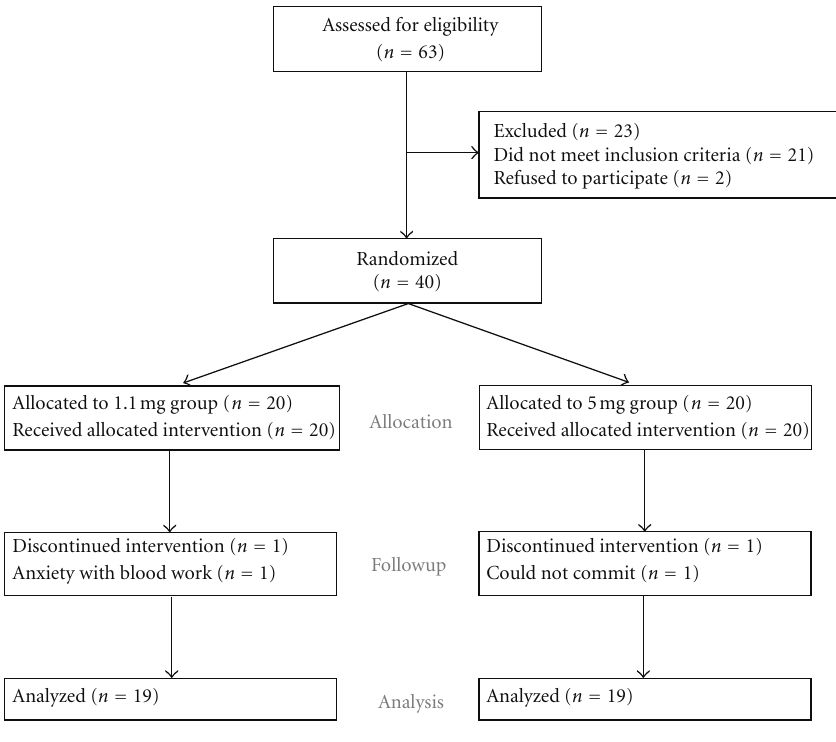
Figure 2: Consolidated Standards of Reporting Trials (CONSORT) patient flow